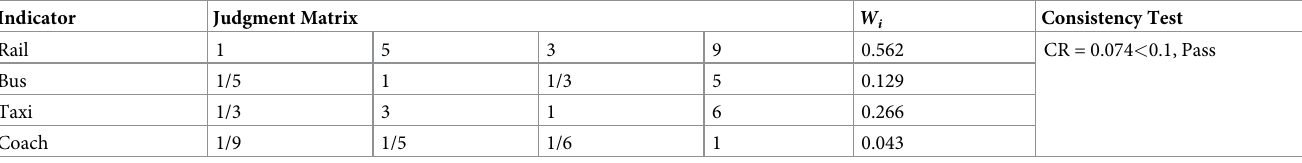
Table 9. Judgment matrix and weight calculation results of the primary index.